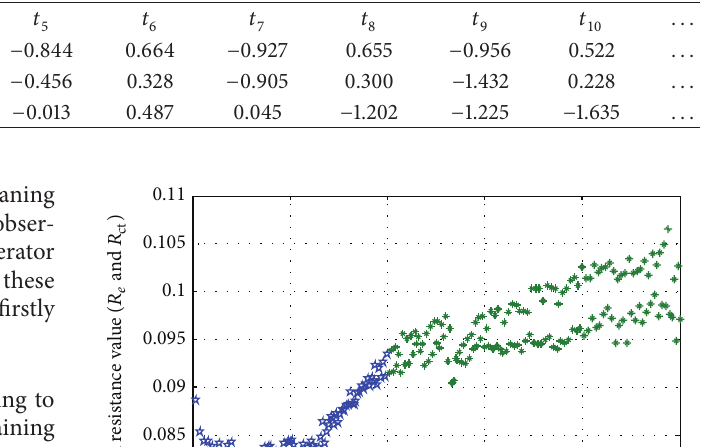
after data normalization process. obs